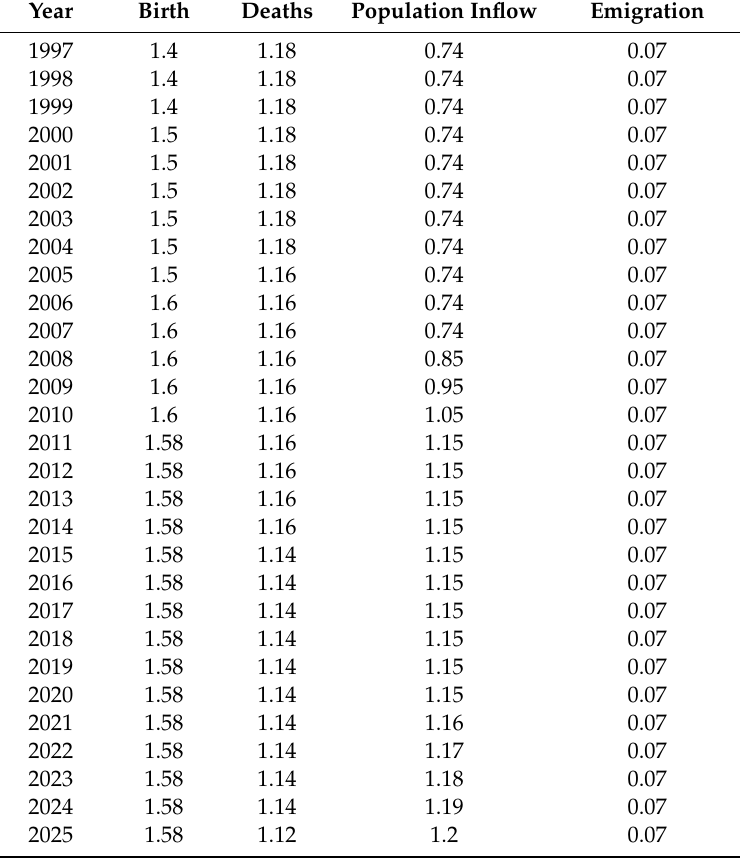
Table 1. List of